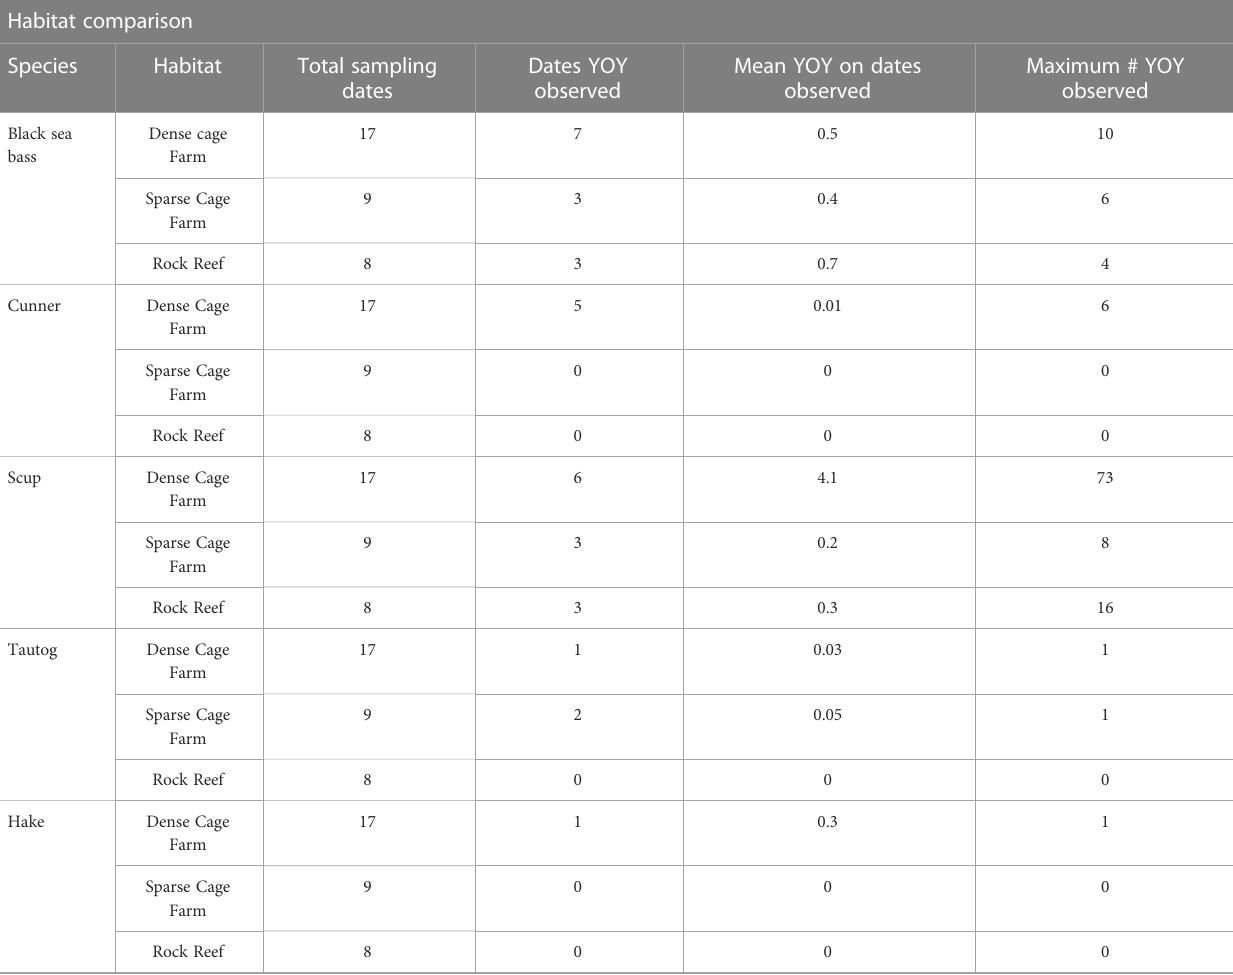
TABLE 3 Summary observations for young-of-year (YOY) fi sh across habitats and across farm locations. Habitat